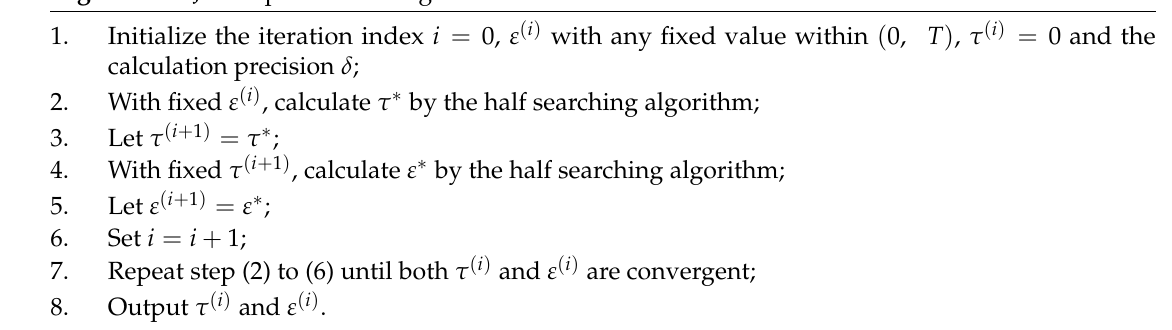
Algorithm 2 Joint optimization algorithm based on